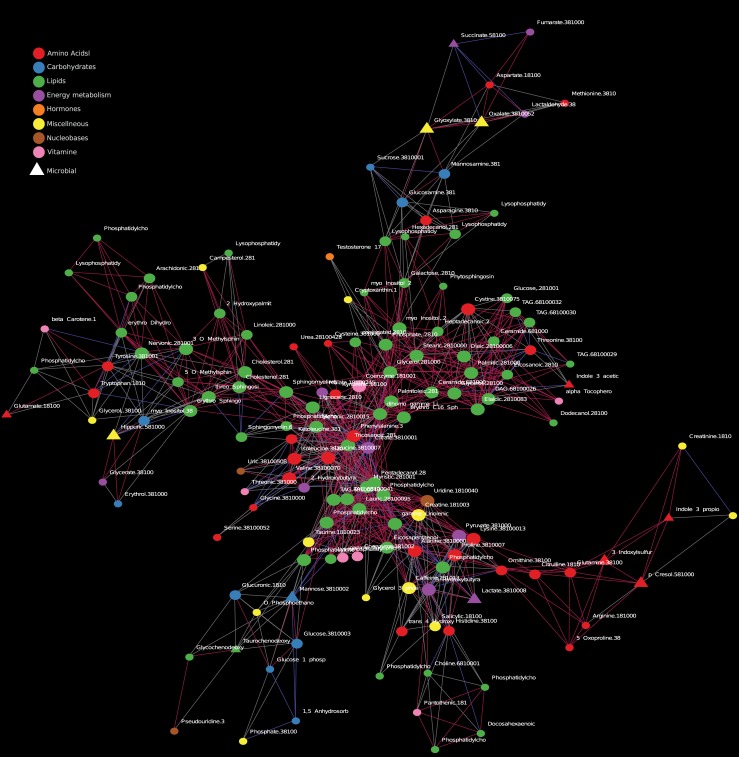
Metabolic network.Association network between metabolites. Red edges indicate positive correlation (Spearman>0.2); blue indicates negative correlation (Spearman<-0.2); and gray are indicative of possible association but no significant correlation. Node size correlates with node degree.